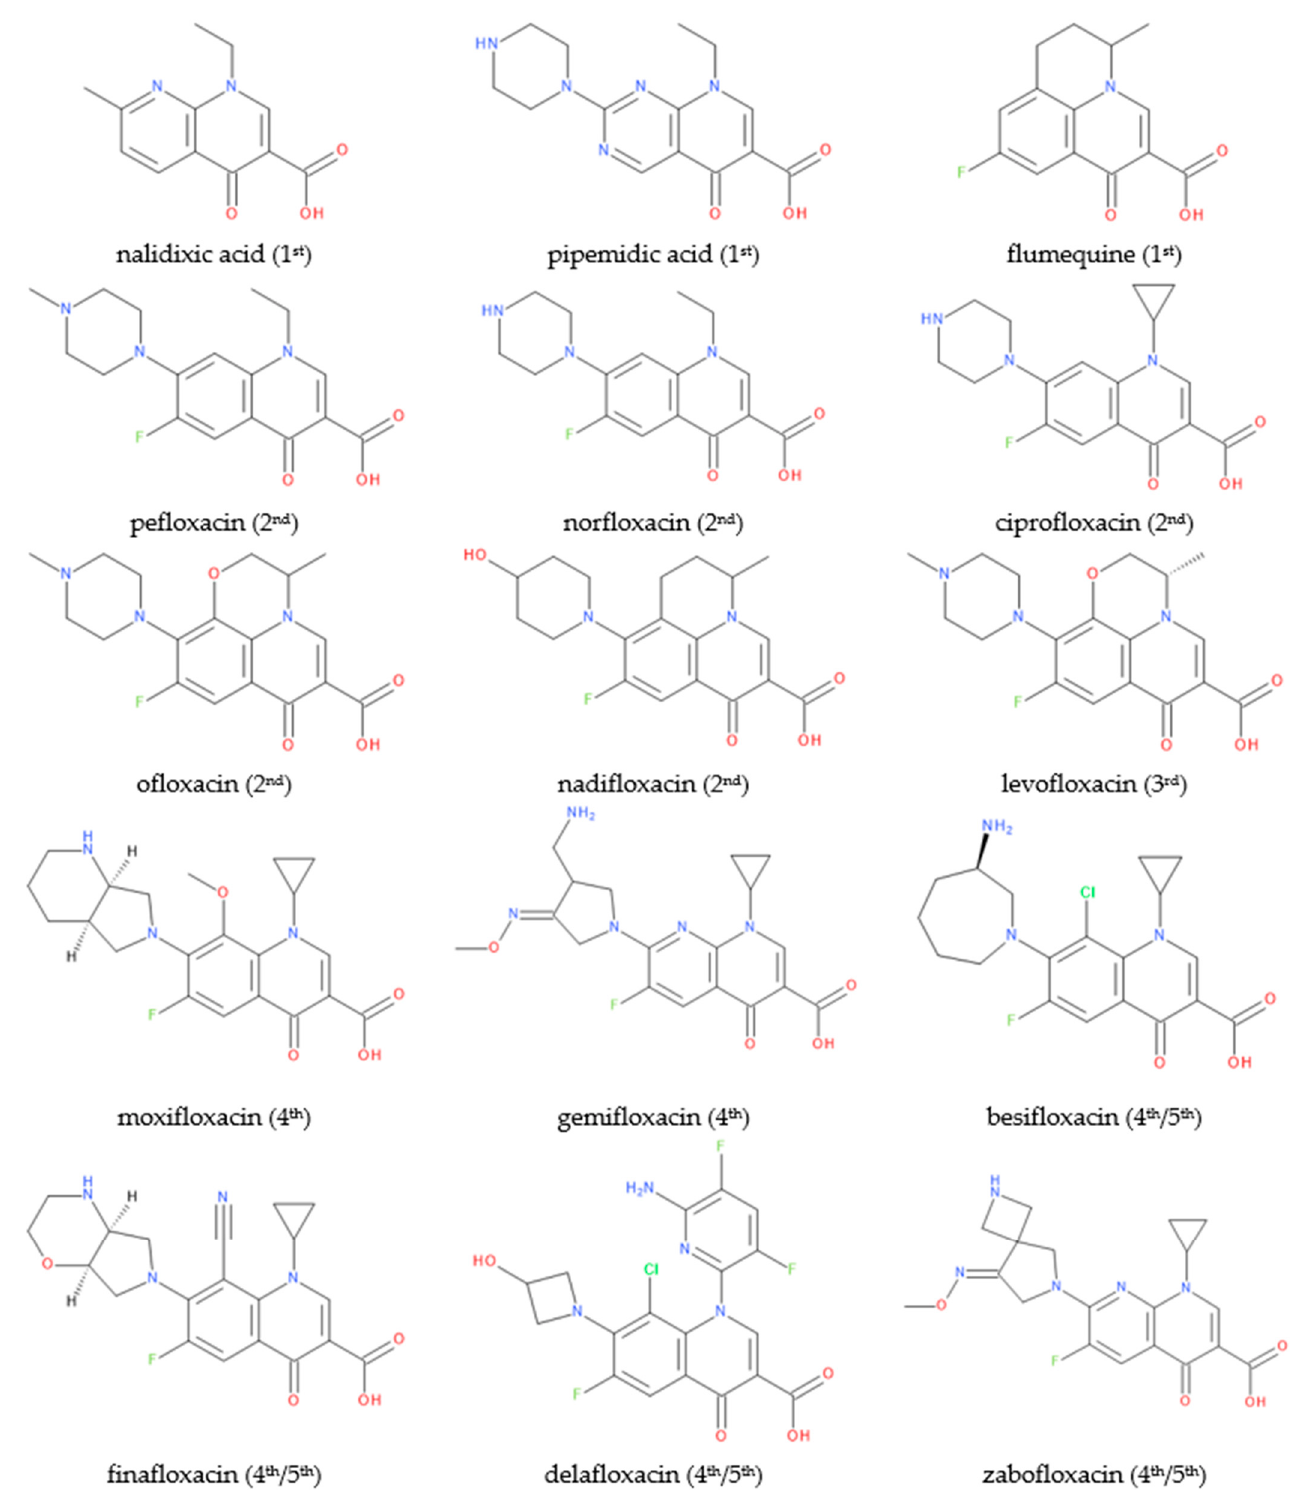
Figure 2. Chemical structures of (F)QNs; the generation is mentioned in parentheses.